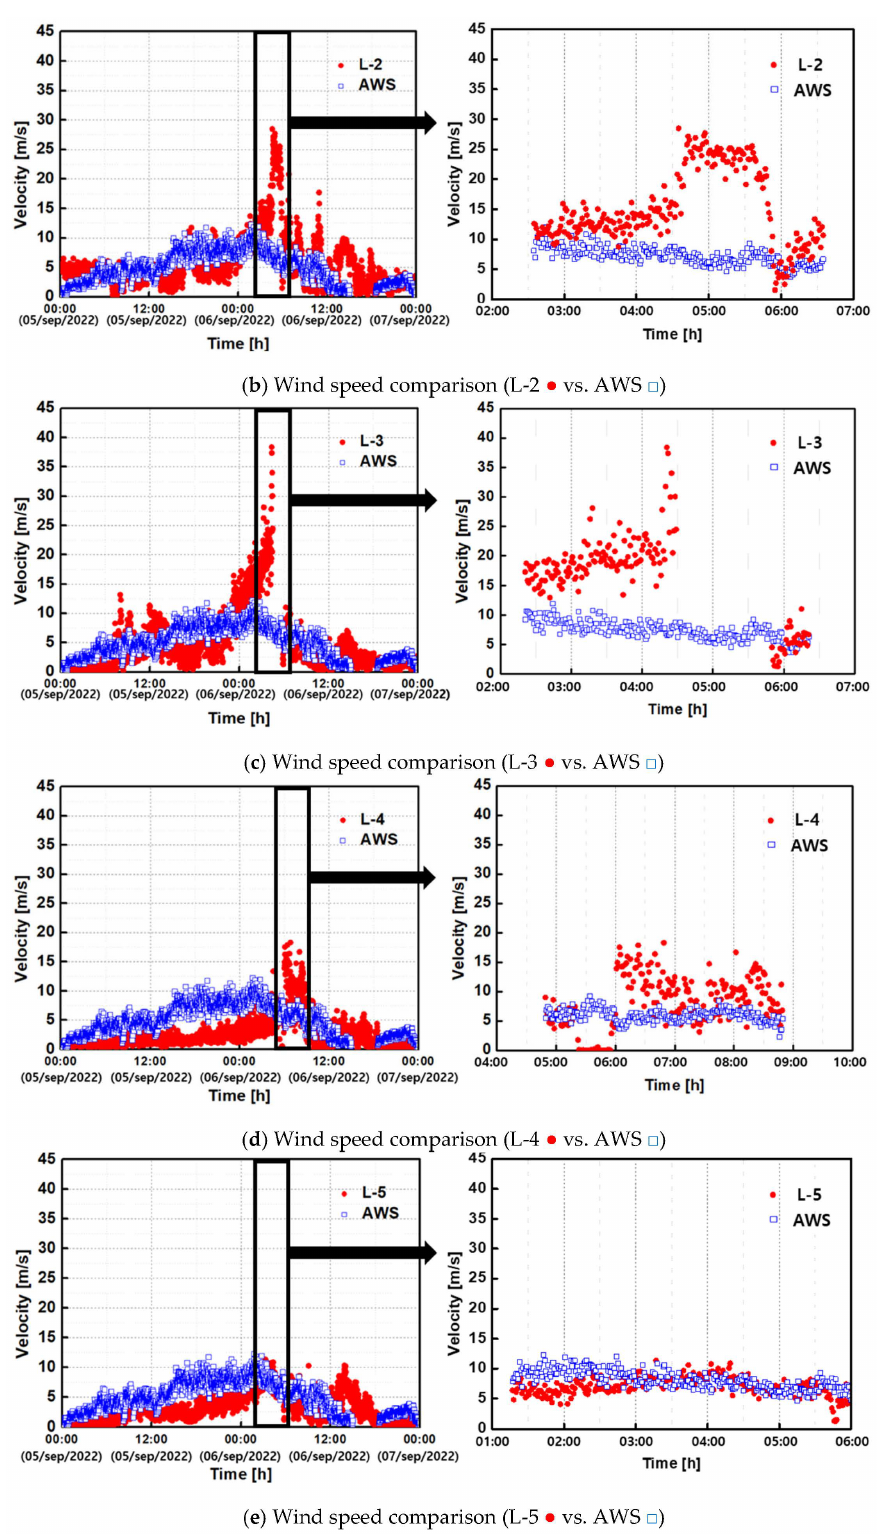
Figure 8. Comparison of the 1-min mean wind speeds over time (LCT residential complex vs.